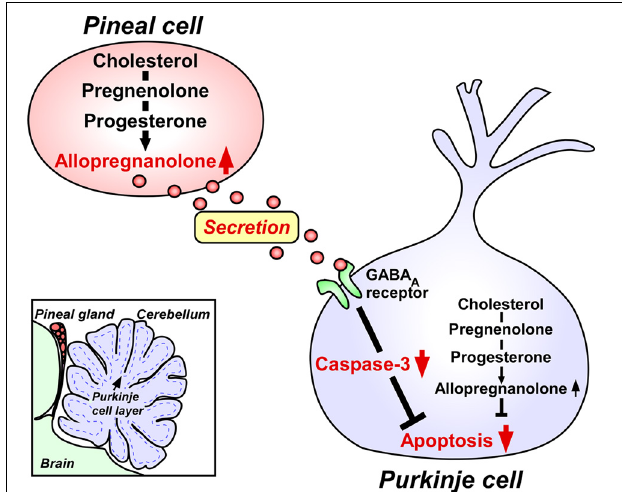
FIGURE 2 | Neuroprotective action of pineal allopregnanolone on Purkinje cell survival during cerebellar development. The square in the left bottom indicates the location of the pineal gland in the quail chick brain. The pineal gland is located adjacent to the cerebellum. Allopregnanolone is exceedingly produced in the pineal gland compared with brain regions, and may affect the adjacent cerebellar Purkinje cells by diffusion, and saves Purkinje cells from apoptosis in the juvenile quail. Secreted pineal allopregnanolone inhibits the expression of active caspase-3 that facilitates apoptosis of Purkinje cells in the cerebellum during development. See Haraguchi et al. (2012b) and the text for